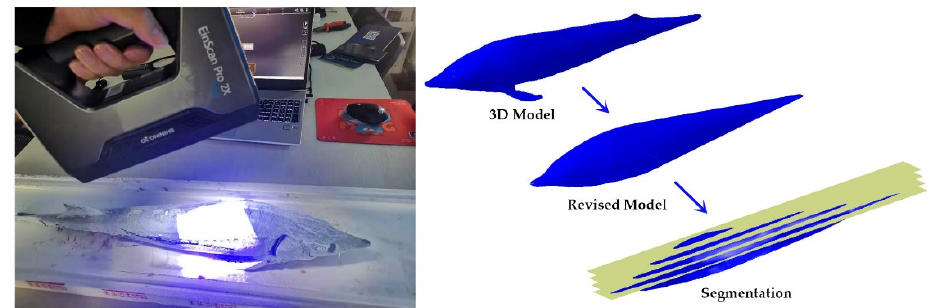
Figure 2. Scanning and 3D model processing method.